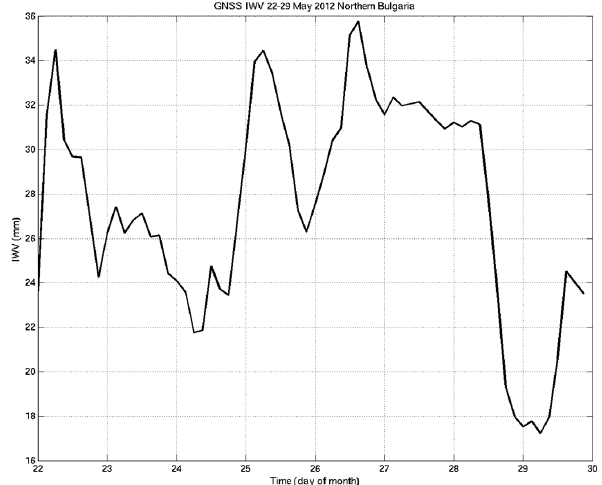
in Fig. 5 at 15:00 UTC over Northern Bulgaria. The water vapour values decrease by 10, to 25 mm (Fig.